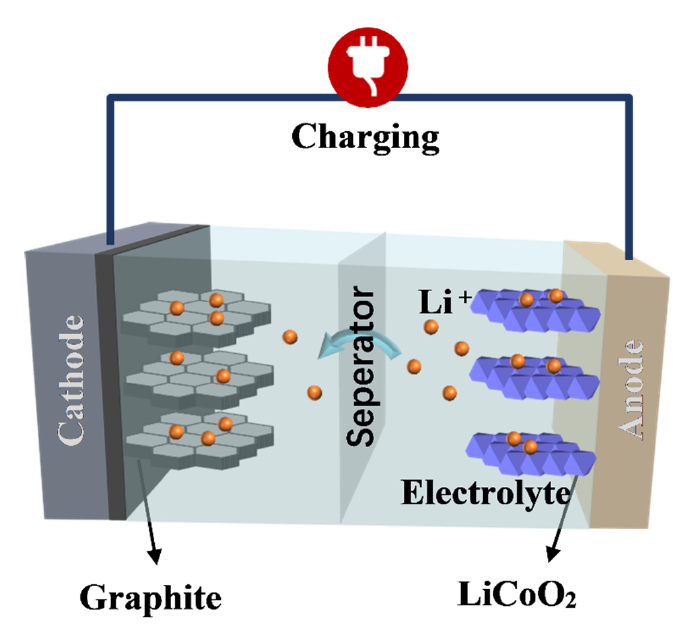
Figure 1. Schematic diagram of lithium-ion battery charging process.